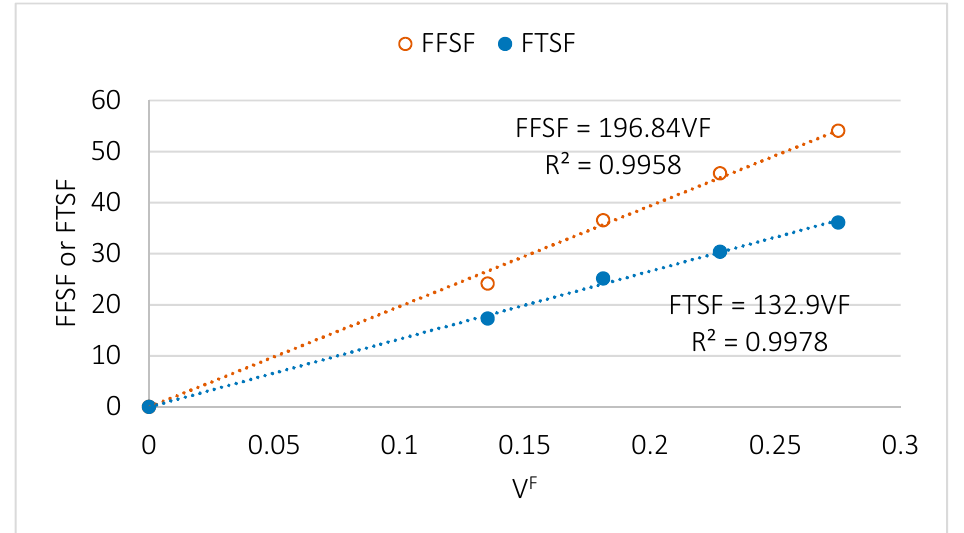
Figure 4. FFSF and FTSF of PLA-BKSF composites. The VF value is the volume fraction of fibers in the composite.